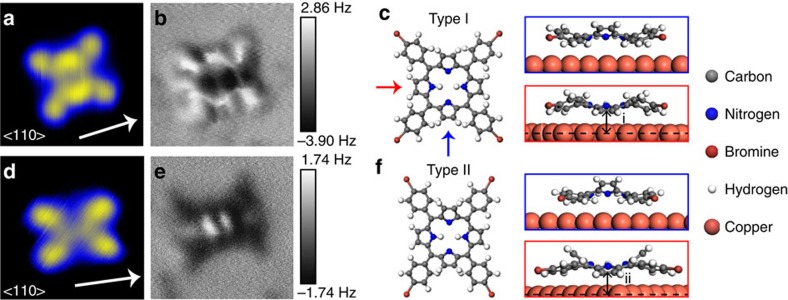
STM and NC-AFM images of Br4TPP conformers on Cu(111).Type I conformers are shown imaged in the (a) constant current STM and (b) constant height NC-AFM modes. Equivalent scans for the Type II conformer are shown in d,e. DFT calculated structures, shown in c,f reveal significant differences in distortion for the Type I and II conformers, respectively. Ball-and-stick illustrations are shown from a top-down view (surface removed for clarity) and two side-on views marked with red and blue arrows and boxes. The C–Cu adsorption distance, marked as i and ii is 2.70 and 2.74 Å for the Type I and II conformers, respectively. STM data were collected in separate experiments. Parameters: STM: (A)-1V/4pA, (d)+1V/50pA. AFM: a0=200 pm, V=50 mV. Image sizes 3.5 × 3.5 nm. STM images are shown with a saturated colour scale.